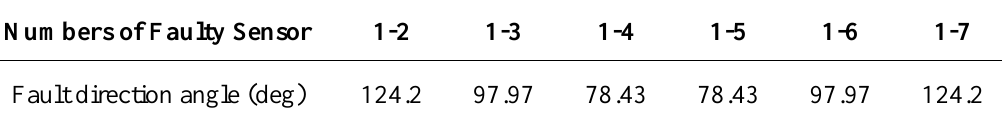
Table 2. Fault direction angle between double faults.